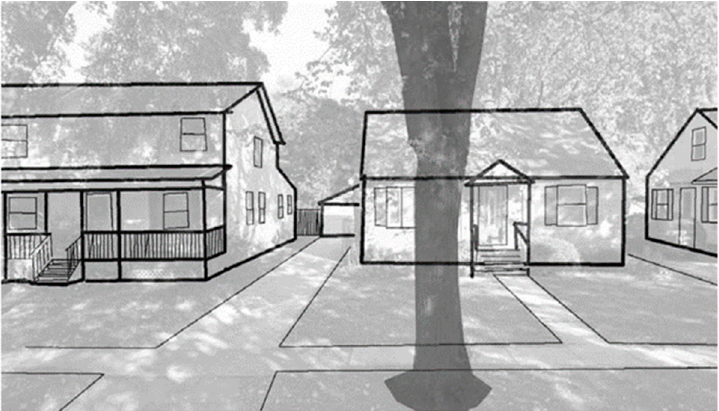
Figure 5. The overall sketch illustrates how the fence at the back of the house is flush with the garage. This is a good example of how to keep occlusivity low.